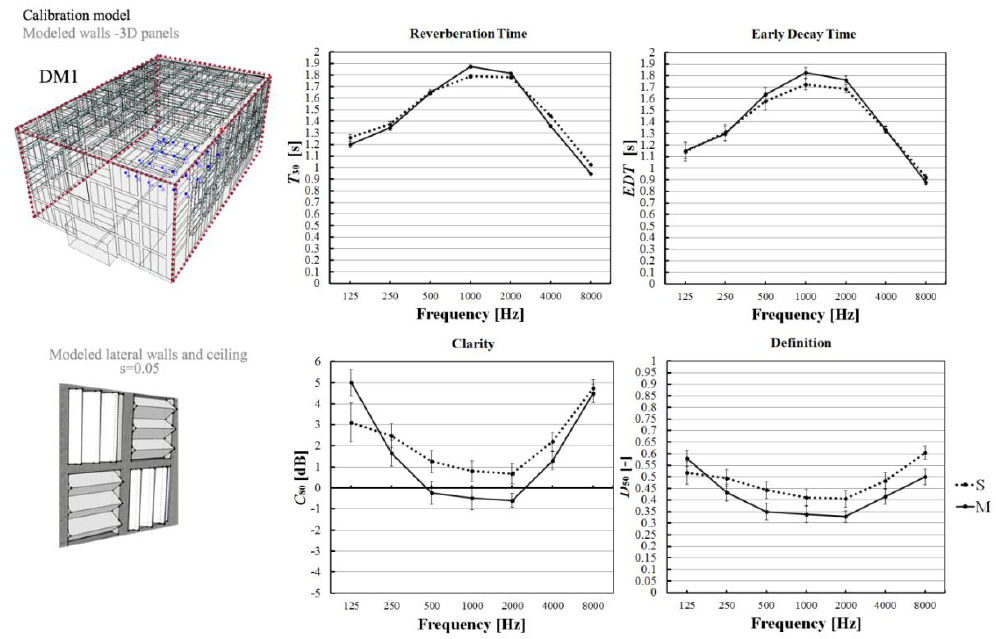
Figure 6. Calibration model (DM1) and objective acoustical parameters obtained after the calibration (Type A and Type B values given for DM1 model materials in Table 1). The diffusive surfaces (3D panels) have been framed in dotted lines. S and M indicate the simulation and measurements results, respectively.